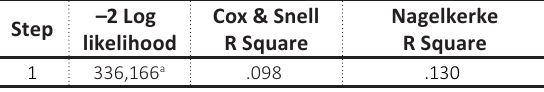
Table 7. Determination coefficient test